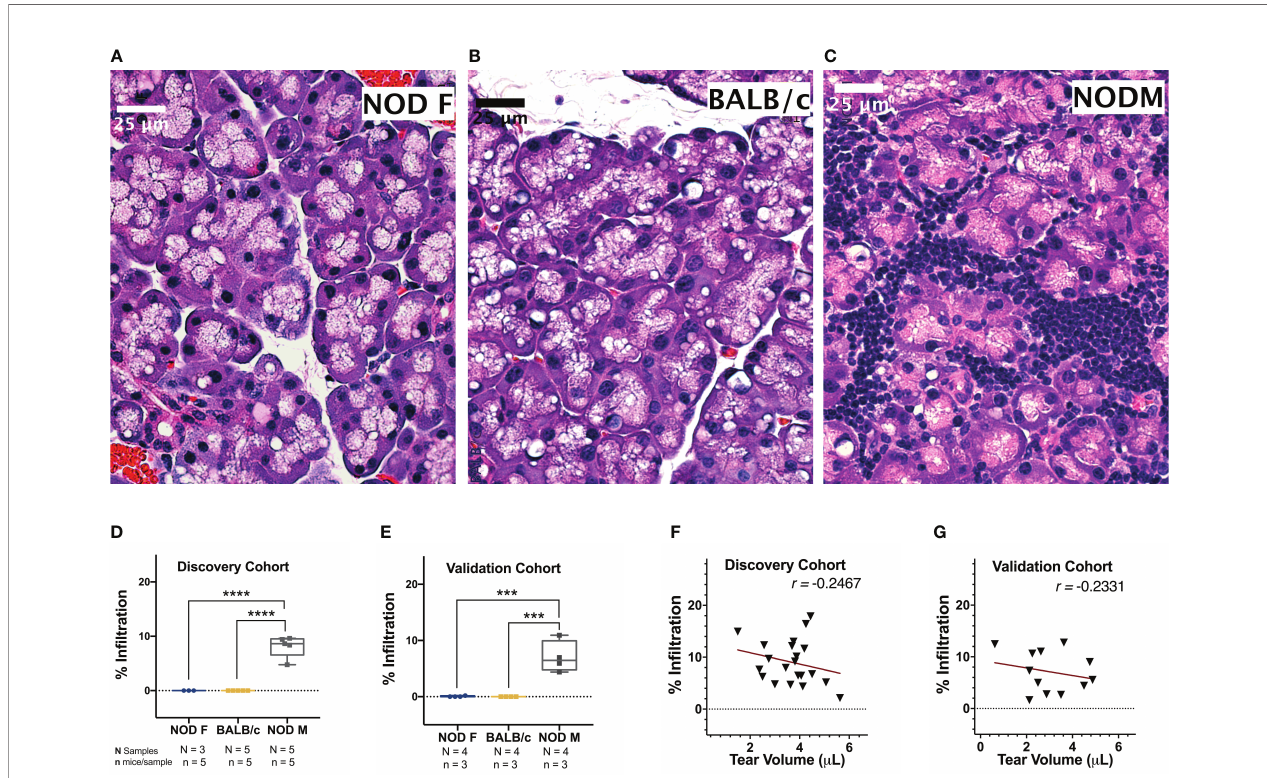
FIGURE 2 | Representative H & E-stained images of LG from 12 -14-week-old female NOD, male BALB/c or male NOD mice. No lymphocytic in fi ltration is observed in LG from (A) female NOD mice or (B) male BALB/c mice. Marked lymphocytic in fi ltration is observed in LG from (C) male NOD mice. Scalebar, 25 m m. The percentage of total area of in fi ltrating lymphocytes in LG calculated in both the (D) discovery cohort and (E) validation cohort of age-matched female NOD mice (blue), male BALB/c mice (yellow) and male NOD mice (grey). Points represent the percentage lymphocytic in fi ltration for one LG per mice. Data are plotted as a boxplot with whiskers showing range. (***p < 10 -3 , ****p < 10 -4 , One-Way ANOVA). The correlation between percentage lymphocytic in fi ltration and tear production for male NOD mice was calculated in both (F) discovery and (G) validation cohorts. Pearson ’ s correlation coef fi cient ( r ) is shown. Points in D-G represent individual mouse LG (D, E) or mouse tears (F, G) with N=25 for male NOD and BALB/c and N=15 for female NOD for discovery cohorts and N=12 for all mouse groups in the validation